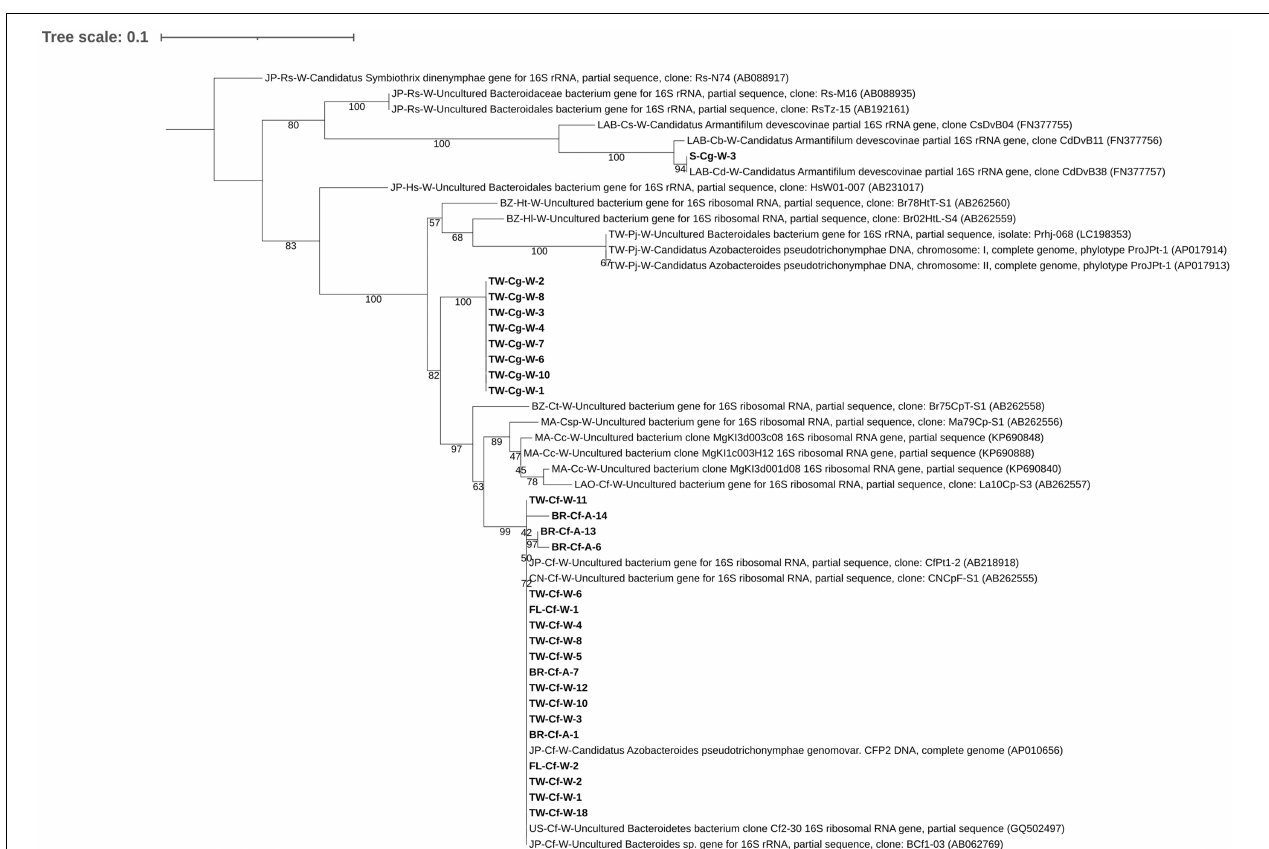
FIGURE 2 | Maximum likelihood tree based on the V3 region of the 16S rRNA gene of Bacteria Candidatus Azobacteroides pseudotrichonymphae (CAP). Reference sequences downloaded from NCBI GenBank are presented with their accession numbers; samples collected for this study are in bold letters. A code for sample location [JP (Japan), TW (Taiwan), BZ (Brazil), LAO (Laos), MA (Malaysia), CN (China Mainland), FL (Florida, United States), United States (New Orleans, LA, United States), BR (Baton Rouge, LA, United States) and LAB (lab reared termites)], termite species [Cf ( Coptotermes formosanus ), Cg ( Coptotermes gestroi ), Cc ( Coptotermes curvignathus ), Ct ( Coptotermes testaceus ), Ht ( Heterotermes tenuis ), Hl ( Heterotermes longiceps ), Pj ( Prorhinotermes japonicus ), Rs ( Reticulitermes speratus ), Csp (an unidentified Coptotermes sp. ), Cs ( Cryptotermes secundus ), Cb ( Cryptotermes brevis ) and Cd ( Cryptotermes dudleyi )], and caste [W (worker) and A (alate)] was added to the sequence description if known. In addition, CAP close related bacteria Candidatus Symbiothrix dinenymphae identified in R. speratus termite and Candidatus Armantifilum devescovinae were included as outgroup. Node support values were obtained from 1,000 bootstrap replications. A detailed reference sequence list was submitted in Supplementary Table 2